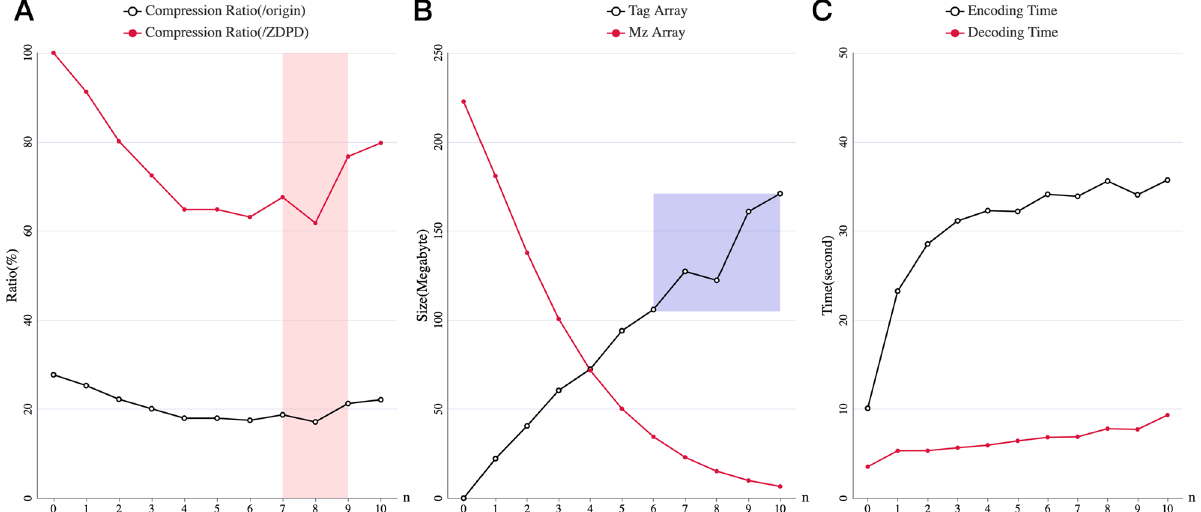
Figure 1. ( A ) Curve of MS data compression ratio-change along with n. The black line with empty circle is generated from size of data compressed with SZDPD divided by size of original arrays, and for red curve with circle, divided by size of ZDPD-compressed arrays. ( B ) The size of tag array and m/z array varies with n, respectively. Data compressed with SZDPD is composed of tag array and m/z array, and the change curves of the two arrays are represented by black line and red line respectively. ( C ) The growth curve of encoding and decoding time as n